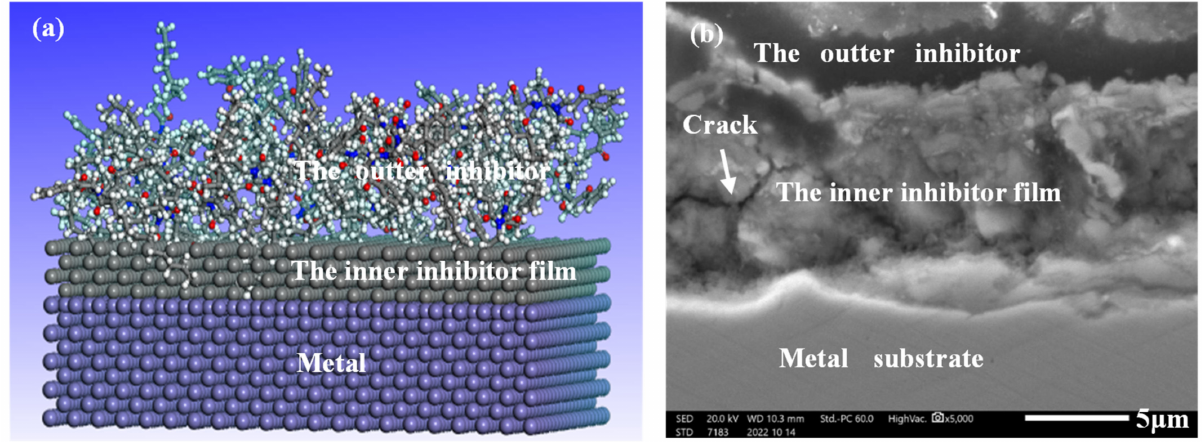
Figure 14. Structure of high-temperature acidizing corrosion inhibitor double-layer film (( a ) schematic diagram, ( b ) section SEM).